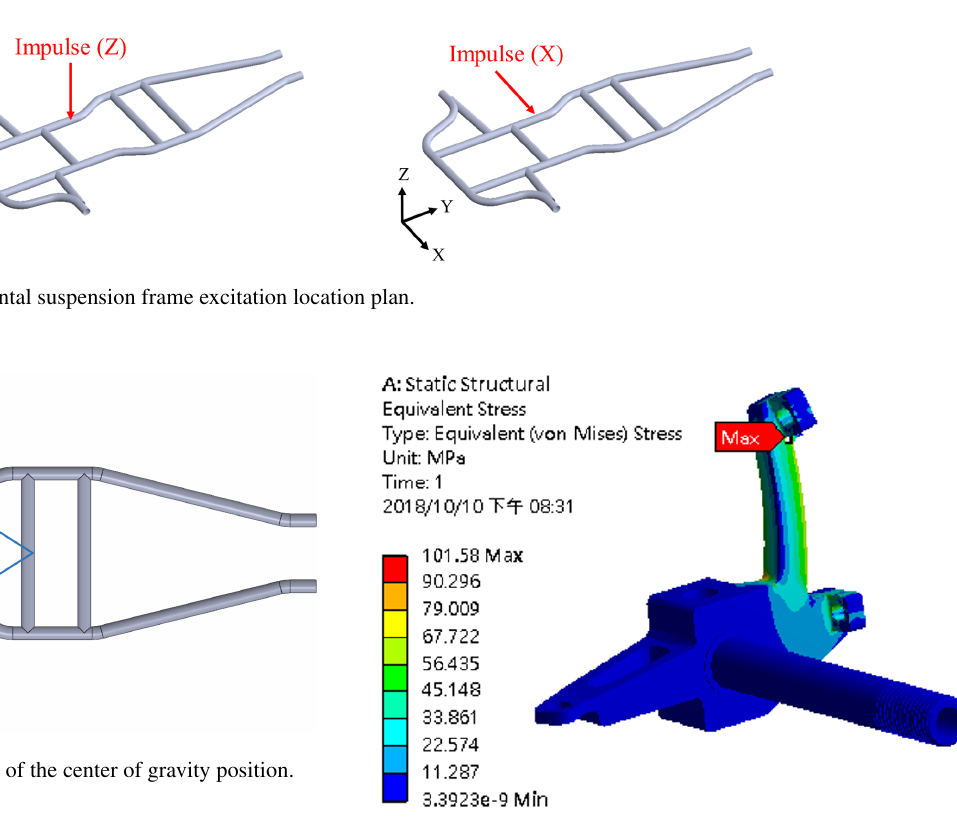
Figure 25. Schematic diagram of the vertical and horizontal suspension frame structures.